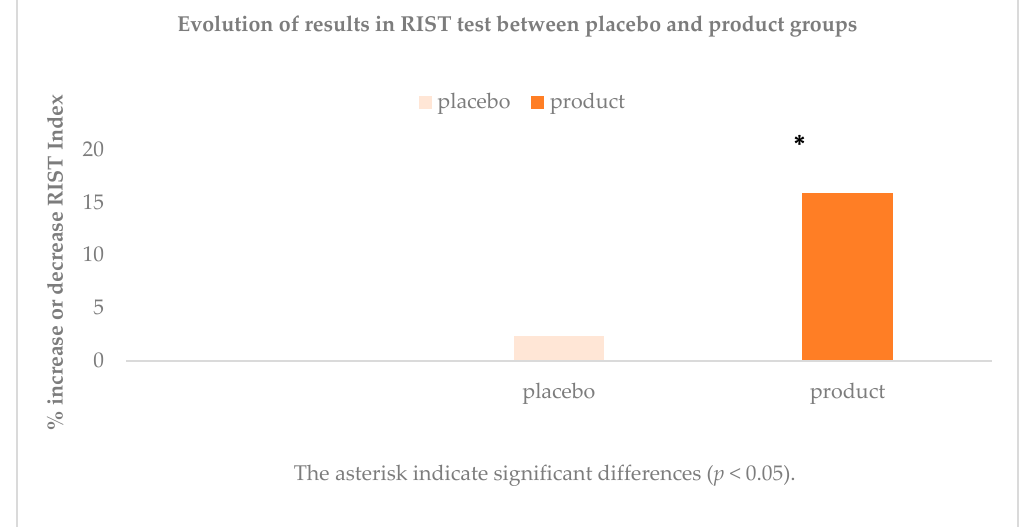
Figure 4. Evolution of results in RIST test between placebo and product groups in percentage increase or decrease. * indicate significant differences. ( p < 0.05). Table 4. Evolution of results obtained over time in RIST test with product and